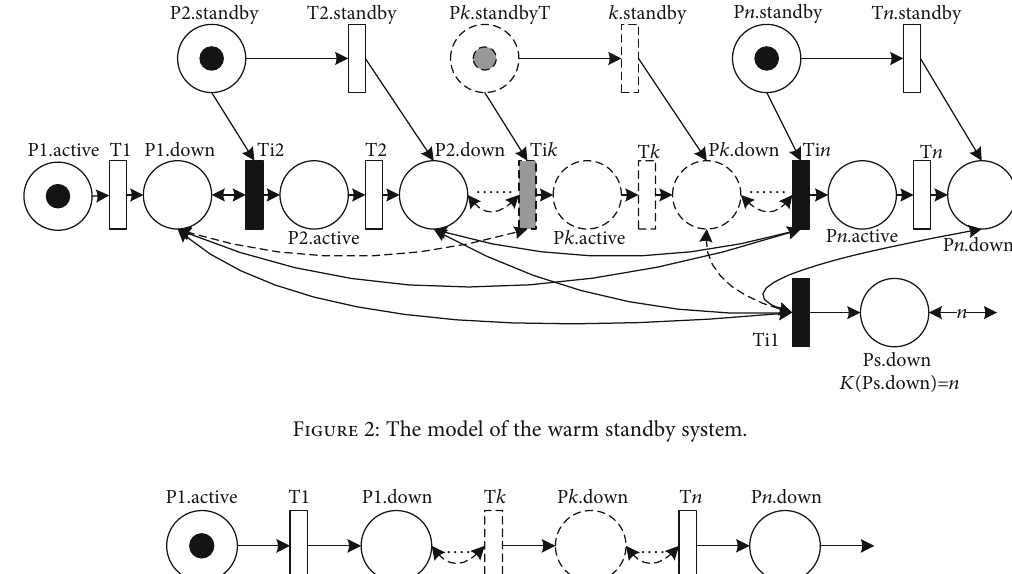
Figure 3: The model of the cold standby